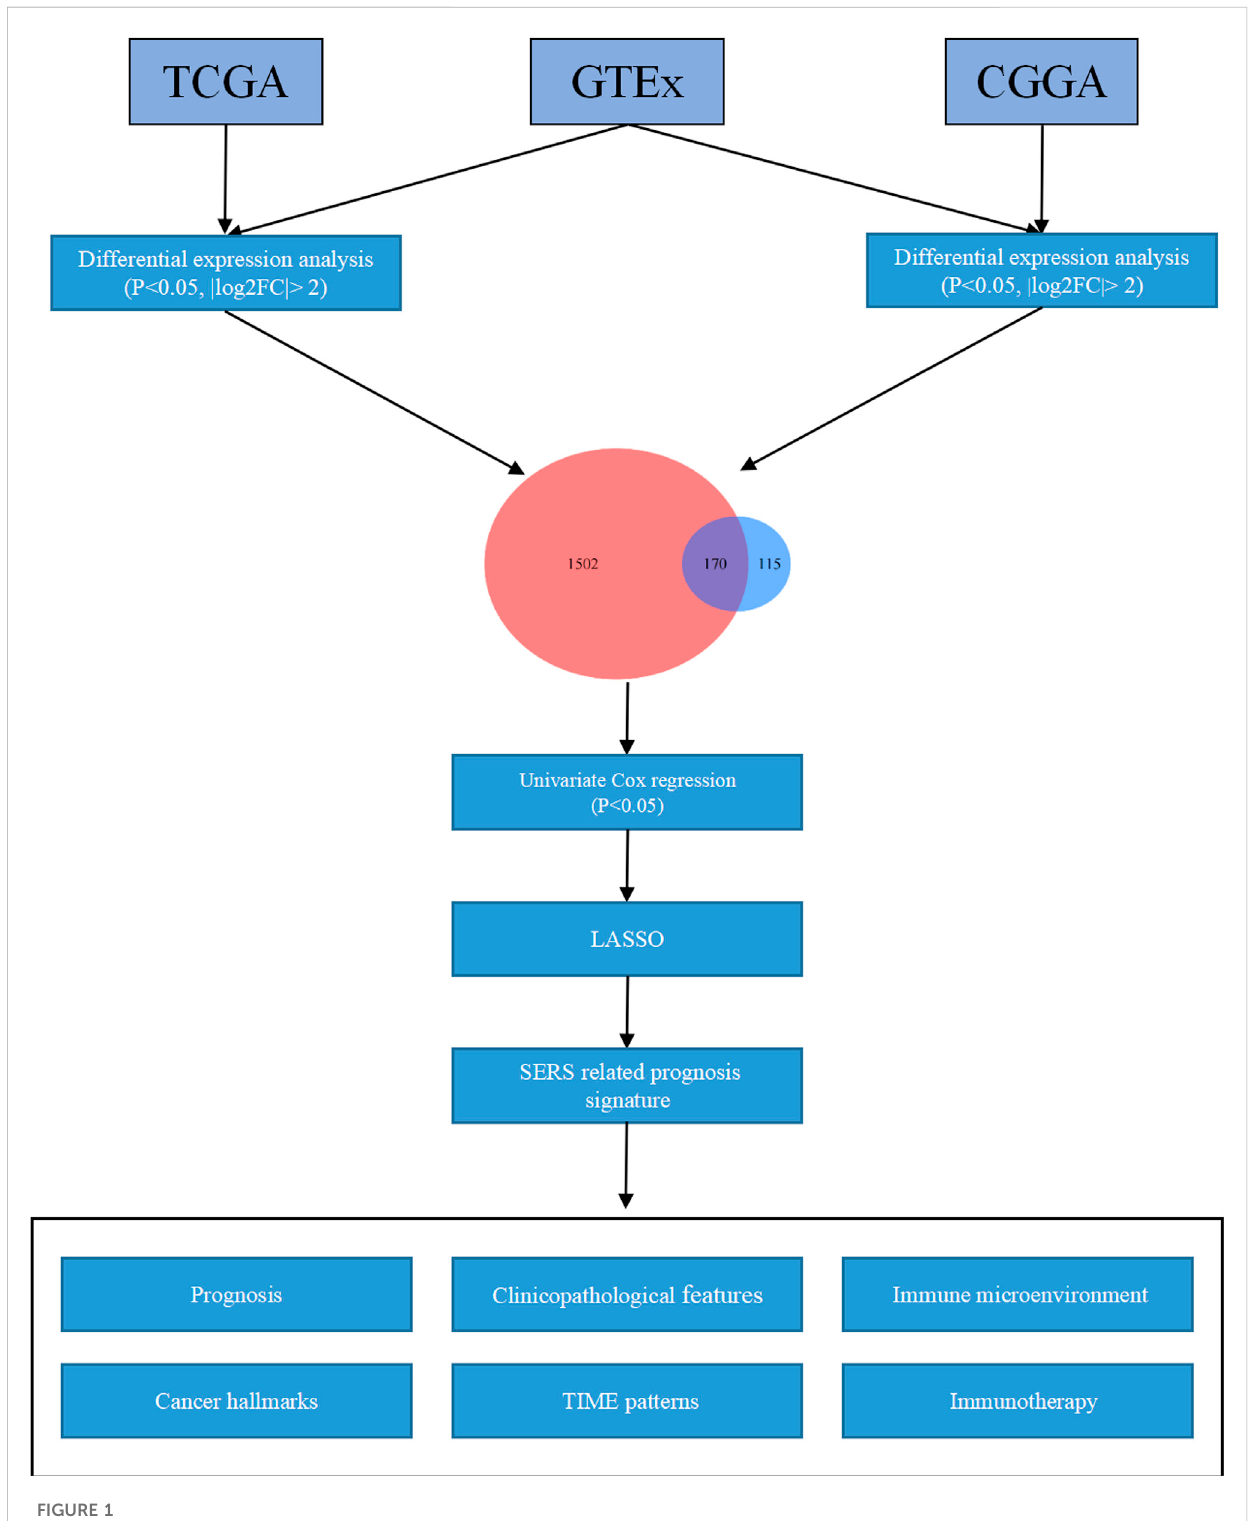
FIGURE 1 The overall fl ow chart of the